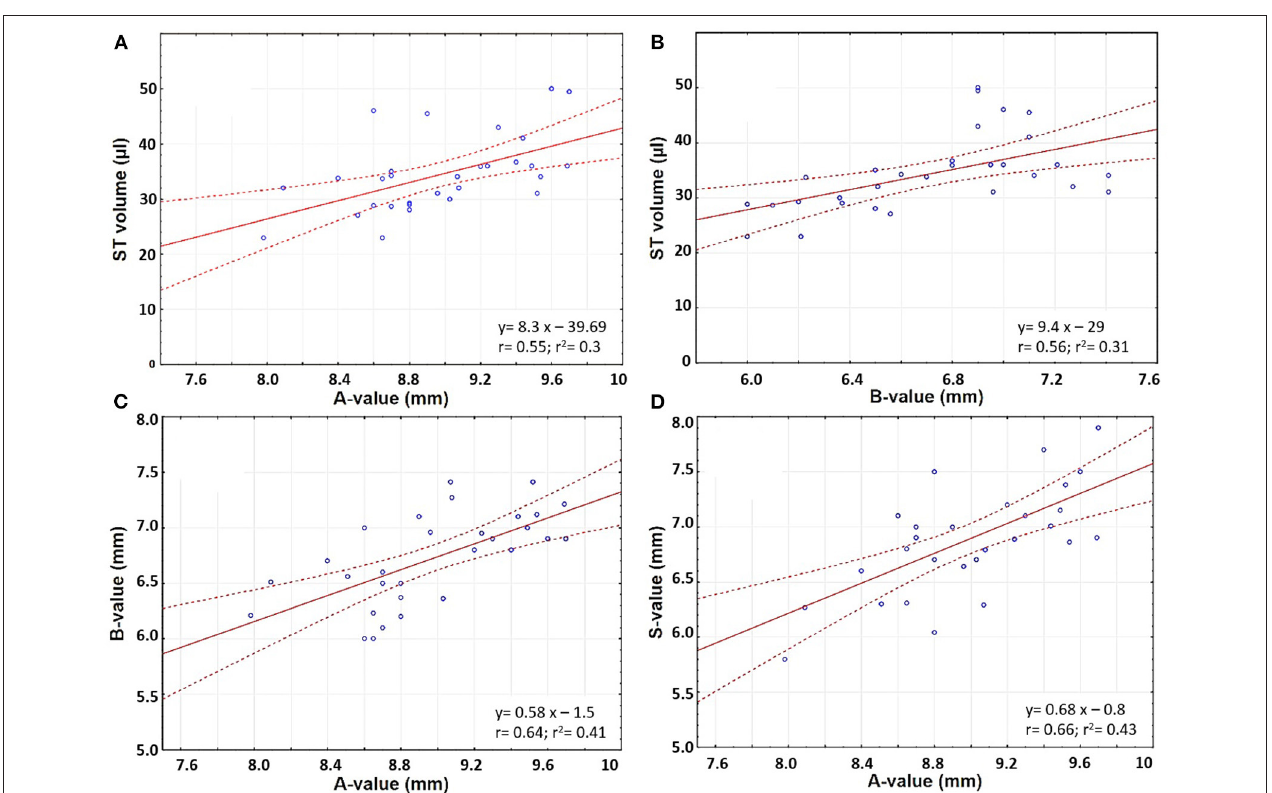
FIGURE 4 | Scatter plots comparing (A) A-value and ST volume; (B) B-value and ST volume; (C) A- and B- values; and (D) A- and S-values.